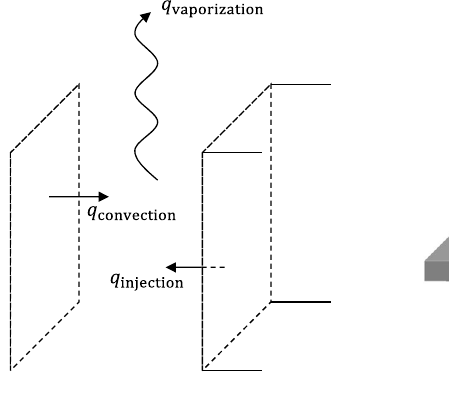
Schematic diagram of heat exchange Description of the temperatures at a particular location Figure 5. Heat exchange between hot and cold media.